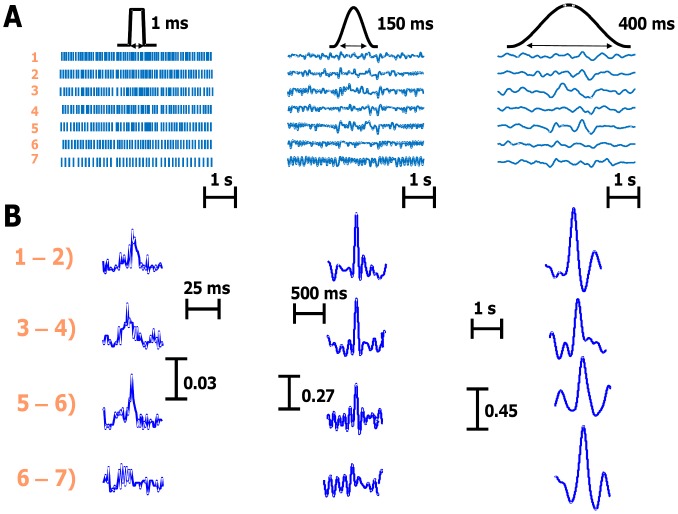
Representative example of the behavior of the correlation measures for seven motor unit spike trains recorded from subject #4.
A, spike trains of seven motor units filtered with 1 ms, 150 ms and 400 ms duration low-pass windows (shown on top). The spike trains are ordered in decreasing discharge rates (6–13 pps). B, cross-correlation functions between pairs of the same filtered spike trains. Note the dependence of the peak correlation on the average discharge rates of the pairs and the length of the filters.